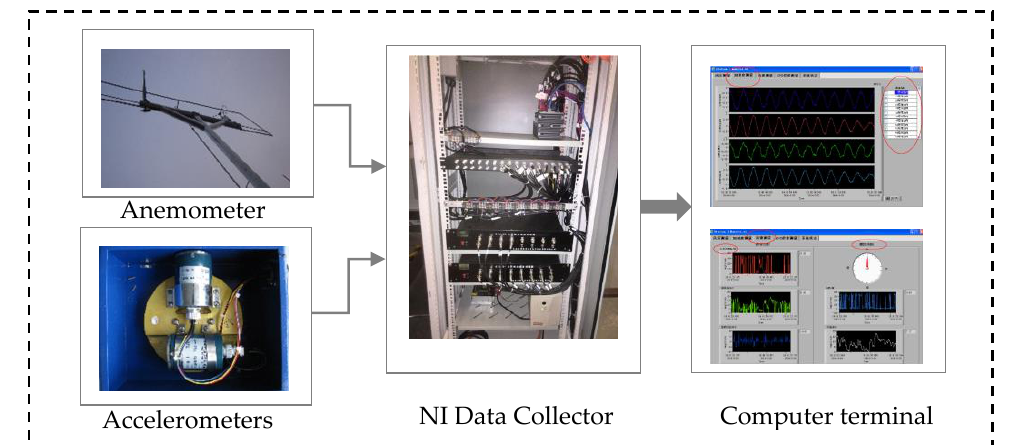
Figure 2. Three functional layers involved in the structural health monitoring (SHM) system. Table 1. Layout of accelerometers installed on Leatop